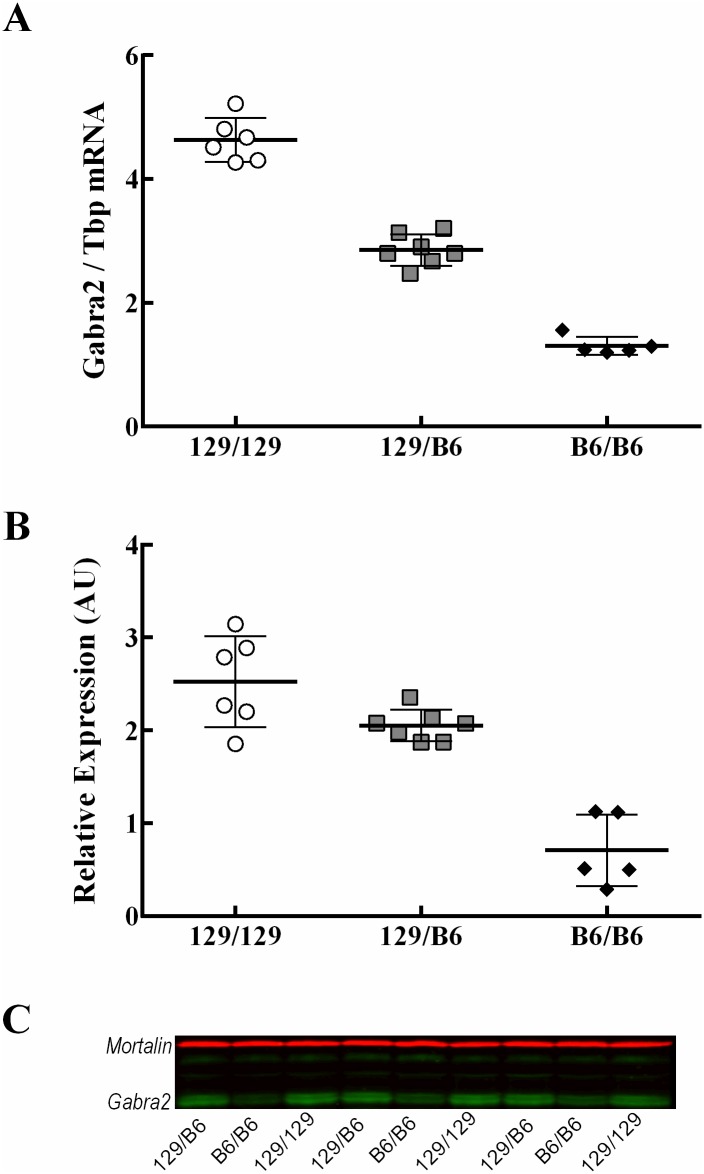
Allele specific Gabra2 transcript and protein expression.A. Relative brain Gabra2 transcript levels between mice carrying 129/129, 129/B6 or B6/B6 alleles in ISC-D were determined by ddRT-PCR and expressed are as a ratio of Gabra2 to Tbp. Highest levels of Gabra2 transcript are observed with homozygous 129/129 alleles, intermediate levels with heterozygosity, and lowest levels with B6 homozygosity. B and C. Brain GABRA2 protein expression for mice carrying 129/129, 129/B6 or B6/B6 alleles in ISC-D was assayed by immunoblotting using a rabbit polyclonal antibody for GABRA2 (Phosphosolutions, 822-GA2C; 1:2000) and a mouse monoclonal antibody for mortalin (NeuroMab 75–127; 1:1000) as a loading control. Relative levels were determined by densitometry and expressed as a ratio of GABRA2 to mortalin. Relative GABRA2 protein expression followed the same trend as Gabra2 transcript. Scatter plot data points represent samples from individual mice (n = 5–6 biological replicates). Average values are depicted as a horizontal bar and error bars represent the SD. Statistical comparison between groups was made using ANOVA with Tukey’s post-hoc tests.